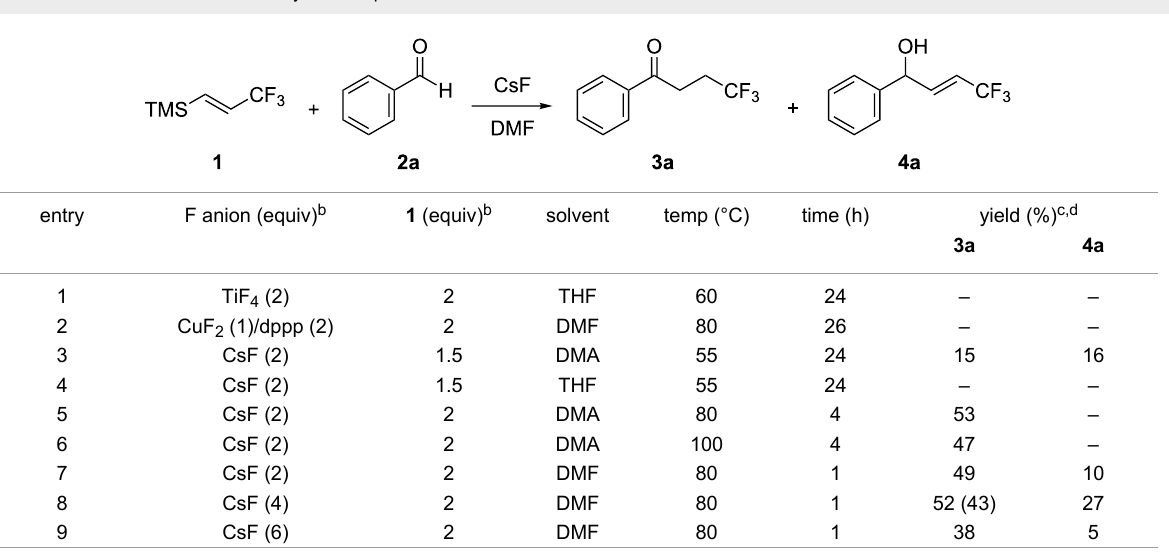
Table 1: Reaction of 1 with benzaldehyde in the presence of fluoride anions.